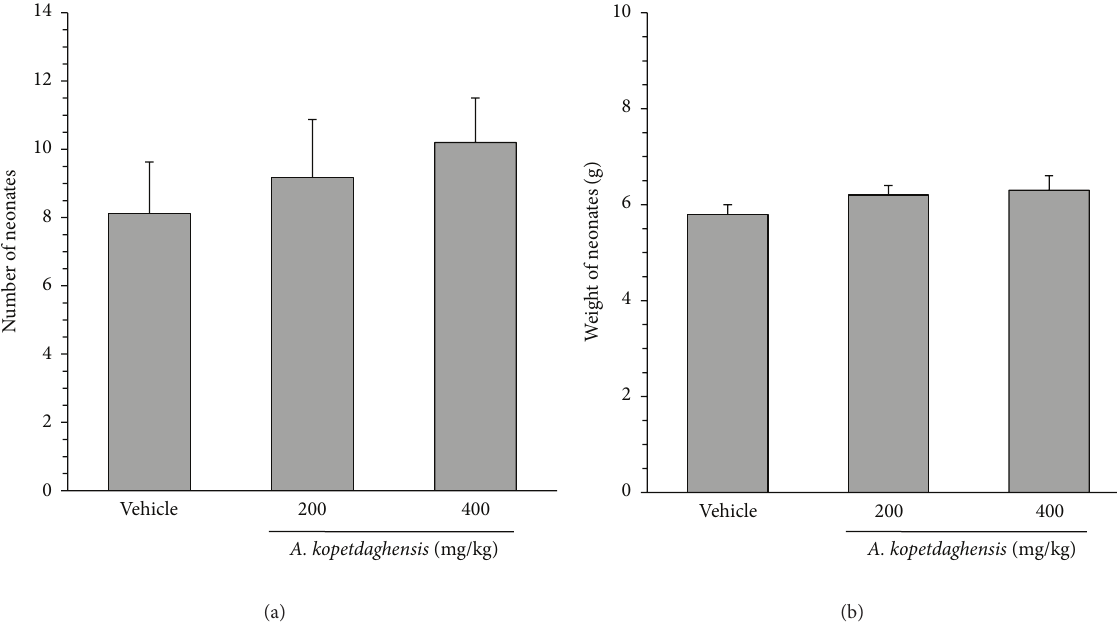
Figure 1: Effect of Artemisia kopetdaghensis hydroalcoholic extract on number (a) and weight (b) of neonates. The pregnant rats were treated (i.p.) with vehicle or 200 and 400 mg/kg of A. kopetdaghensis hydroalcoholic extract from the 2th to 8th day of pregnancy. Values are mean ± SEM ( 𝑛 = 8 – 10 ).